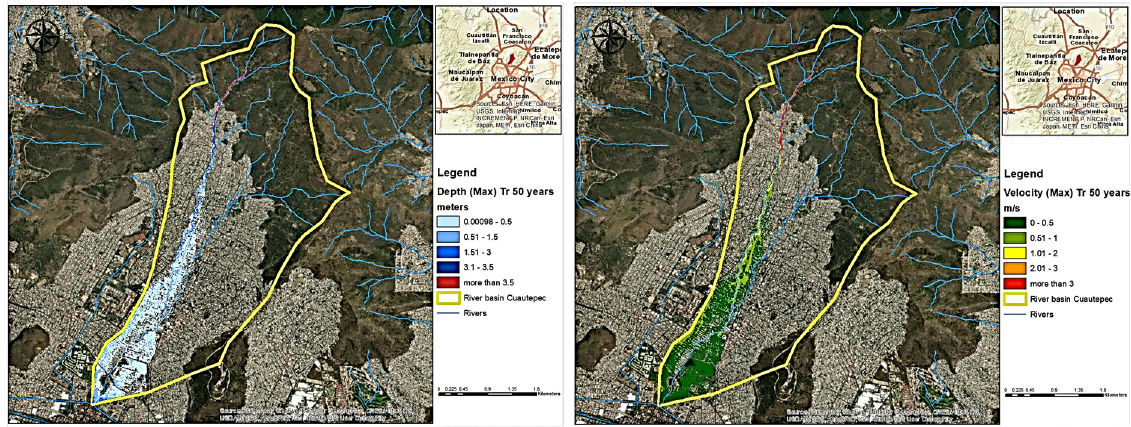
Figure 12. Depths and max velocity, maps for Tr 50 years using Hec ‐ Ras2d.